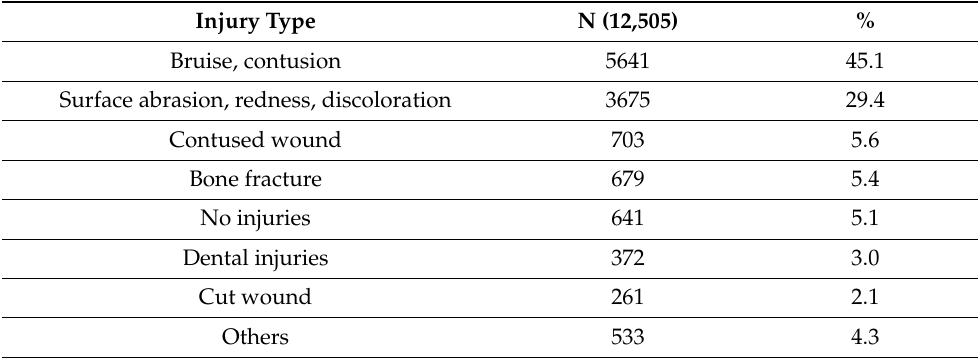
Table 7. Incident classification by type of injury.